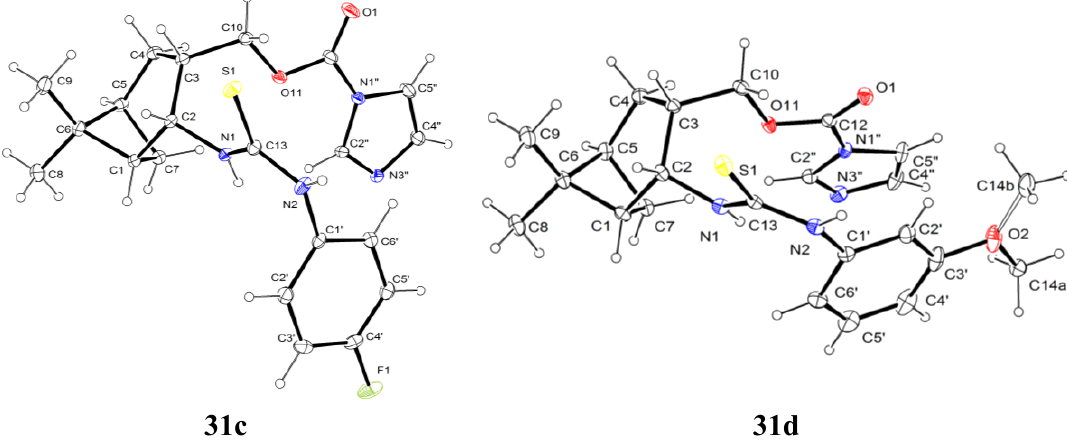
Figure 2. ORTEP plots of the configurations of the major diastereoisomers 31c and 31d (the C atom of the methoxy group (C14) is disordered in a 1:1 ratio).